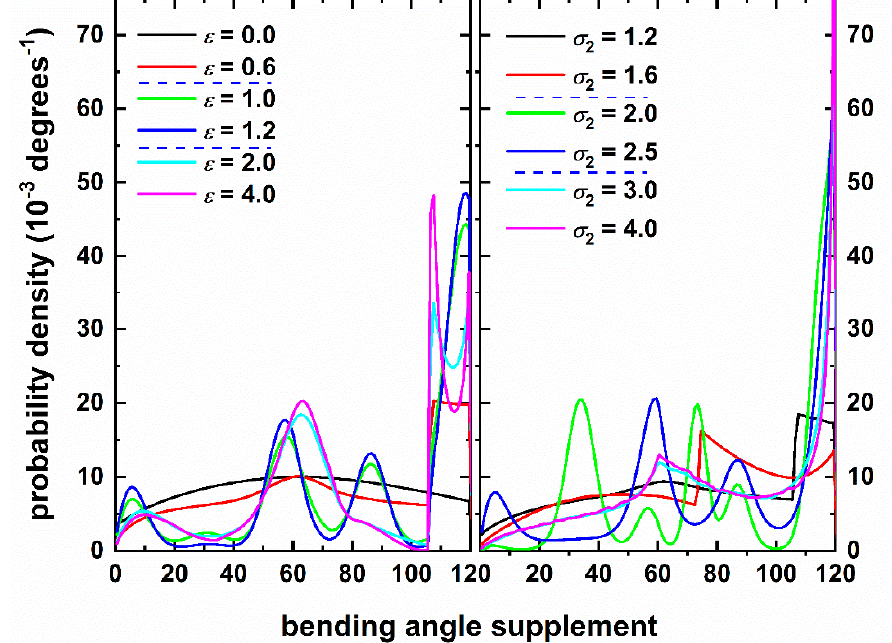
Figure 9. Distribution of bending angle supplement as a function of ( left panel): attraction intensity for fixed range ( σ 2 = 1.2) and ( right panel): attraction range for fixed intensity ( ε = 0.5). Dashed horizontal blue lines in legend identify transitions to different phase regimes: amorphous → crystalline → glassy.